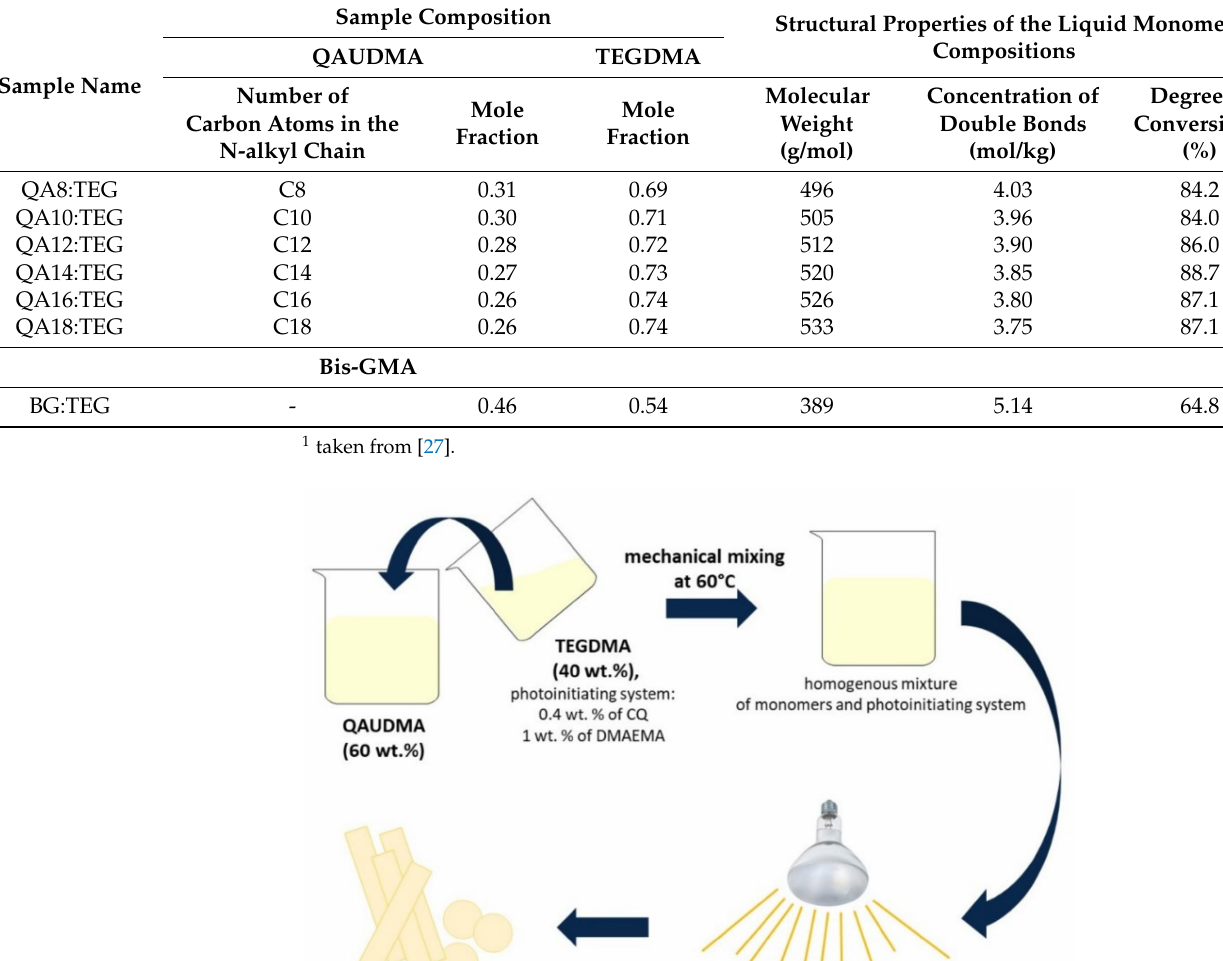
Table 1. Compositions and structural parameters of the studied 60 wt.% QAUDMA and 40 wt.% TEGDMA (QA:TEG) liquid monomer compositions.